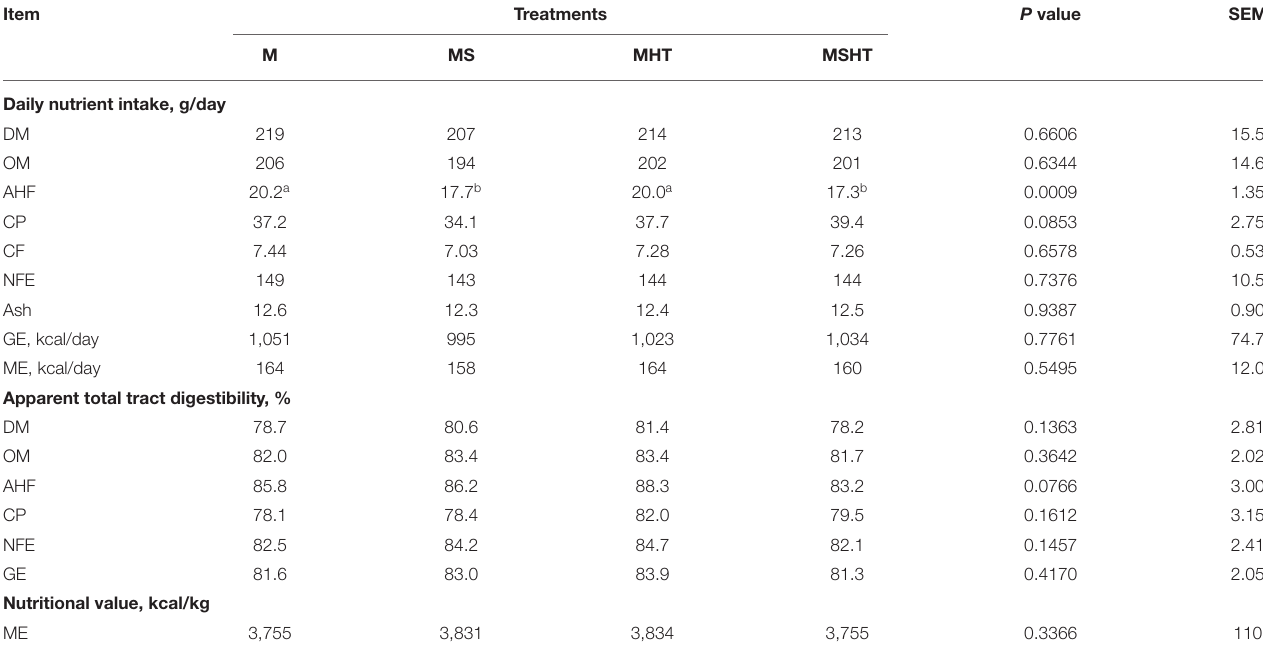
TABLE 5 | Nutrient intake and digestibility of nutrients and energy of dogs fed the experimental